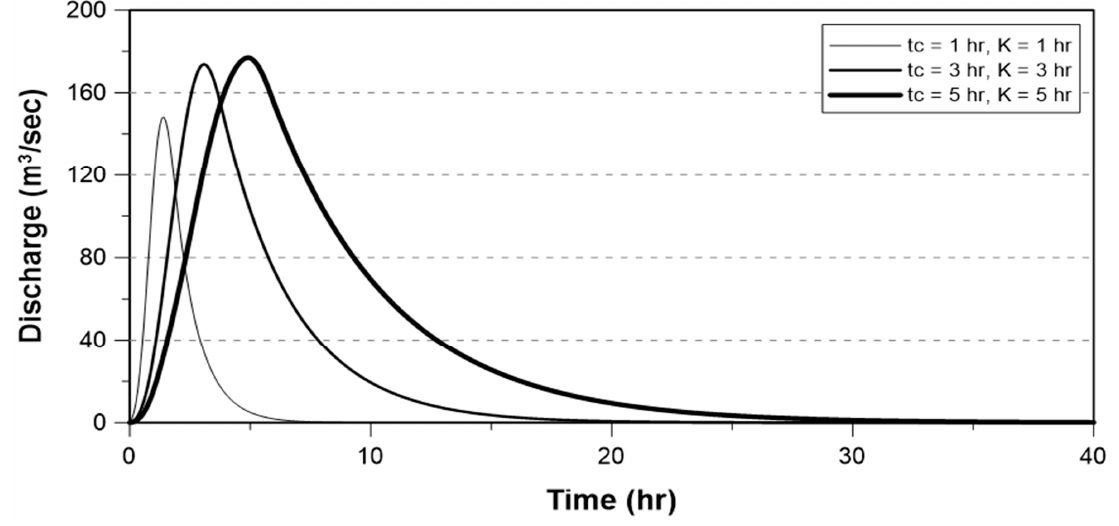
Figure 5. Comparison of 1-h unit hydrographs derived for the three artificial basins.